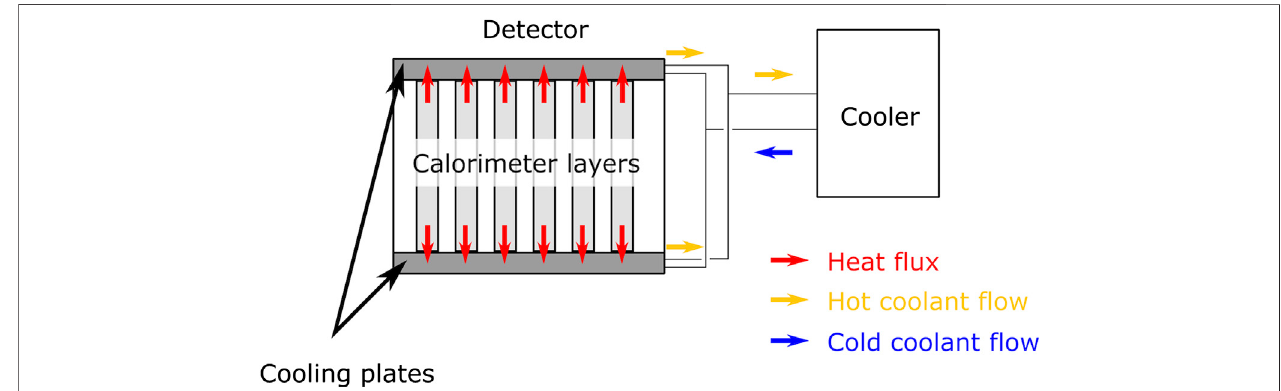
Frontiers in Physics |